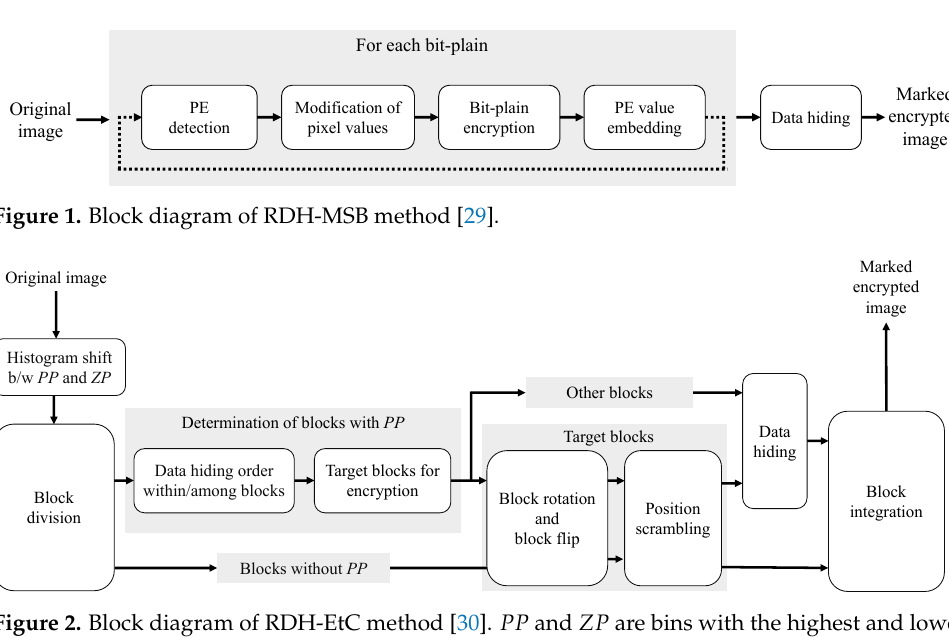
Figure 2. Block diagram of RDH-EtC method [30]. PP and ZP are bins with the highest and lowest frequency, respectively, in original-image